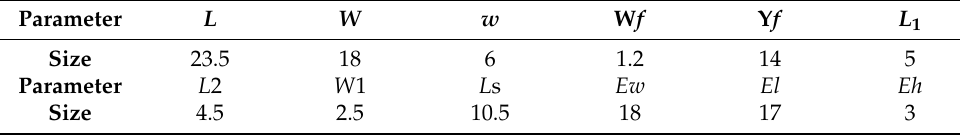
Table 1. Dimensions and size of antenna elements (unit: